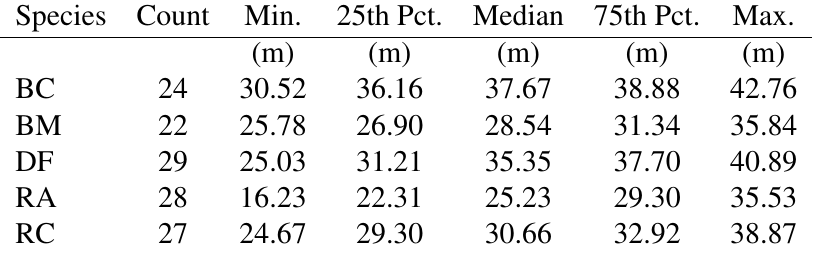
Table 2. Tree height statistics by species of the trees contained in the training data. Species Min. 25th Pct. 75th